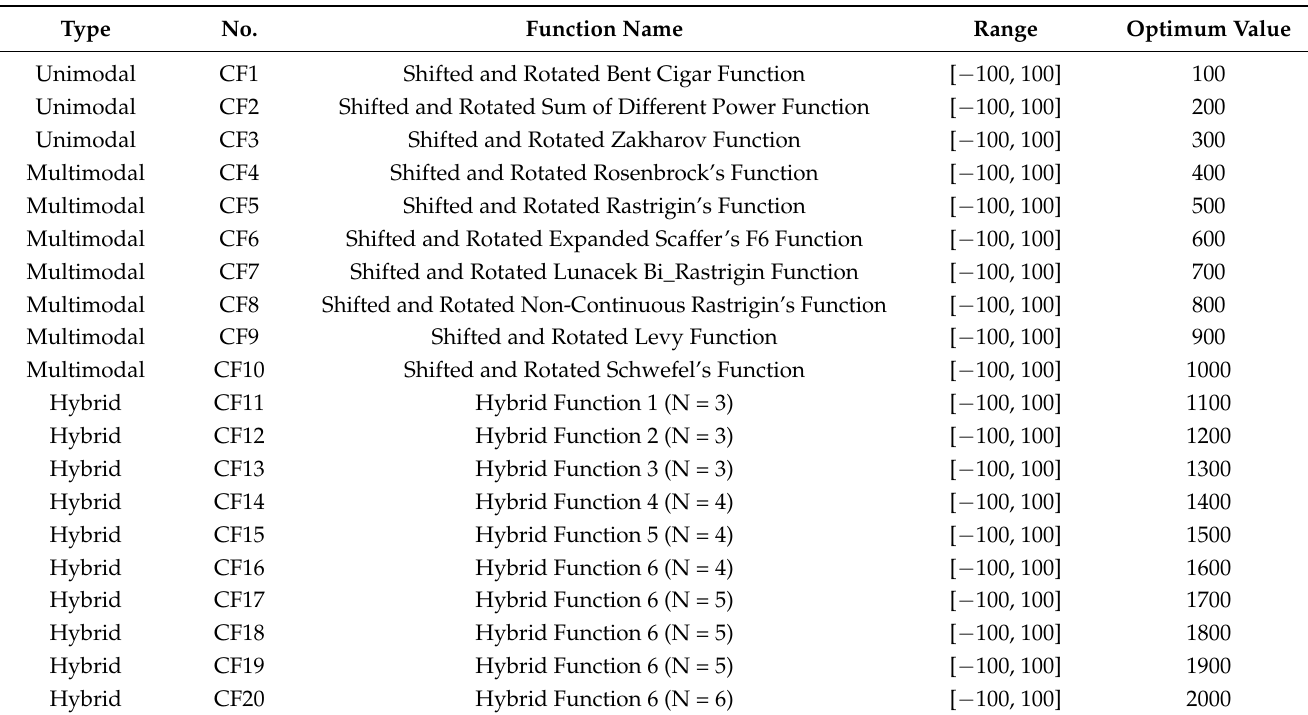
Table 3. CEC2017 numerical optimization